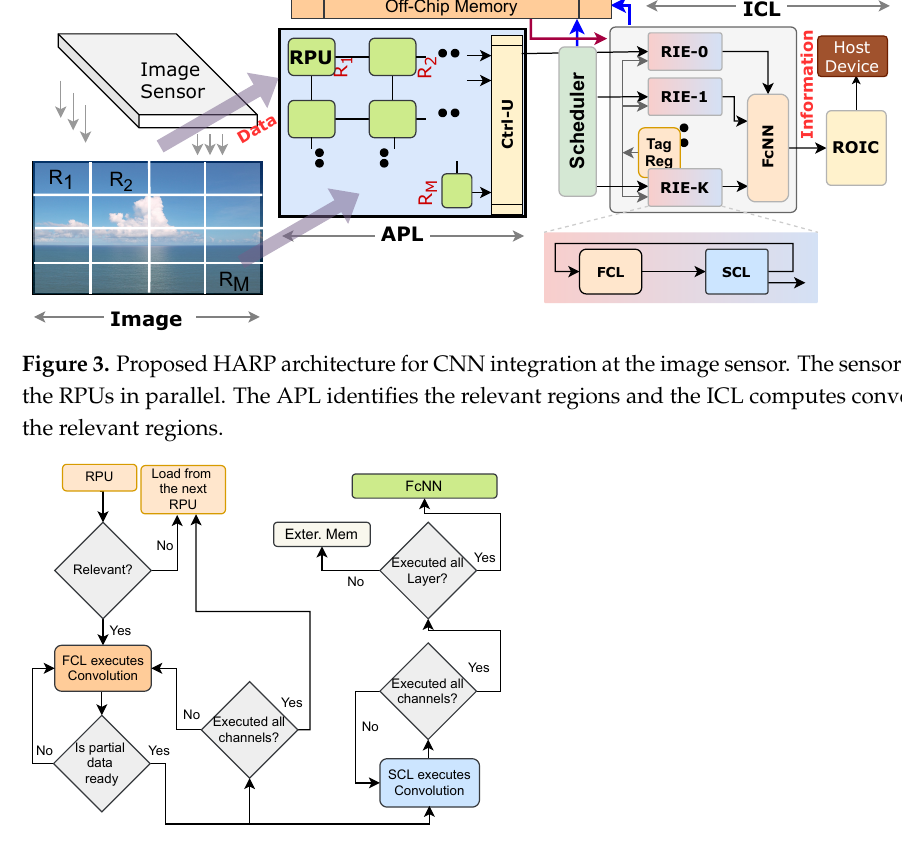
Figure 4. Simplified flowchart of the proposed